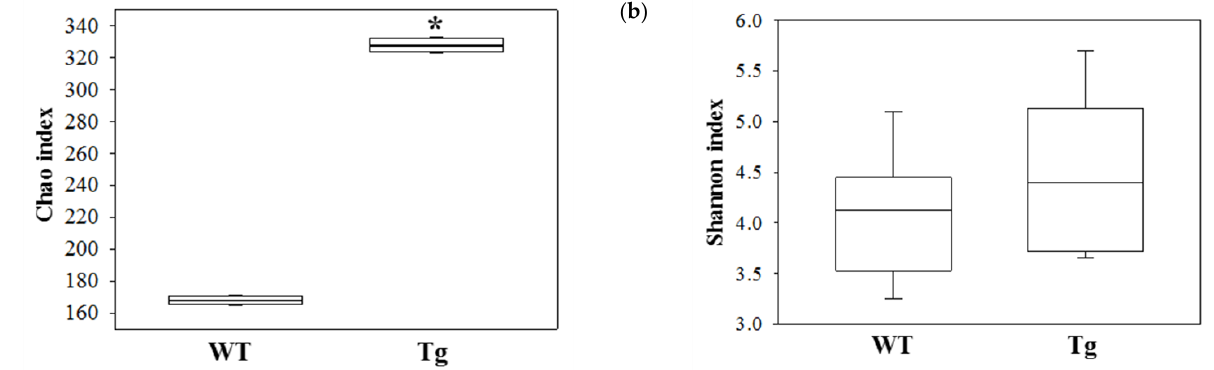
Figure 4. Comparison of ( a ) Chao index and ( b ) Shannon diversity index of the fecal microbiota in Tg2576 mice. The data are reported as mean ± SD values. *, p < 0.05 compared to the WT mice. Abbreviations: WT, wild-type; Tg, Tg2576 mice.